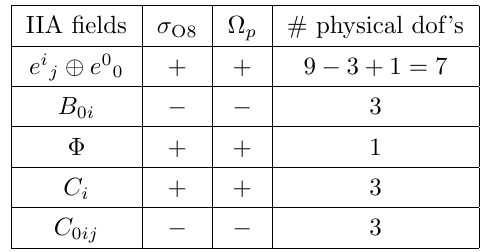
Table 6 . Counting of the total 17 propagating scalar dof’s allowed by O8-planes in type IIA com- pacti(cid:12)cations down to six dimensions. This is exactly the dimension of the supergravity coset given in (3.1), once we subtract from e i j the 3 unphysical directions corresponding to SO(3) generators.